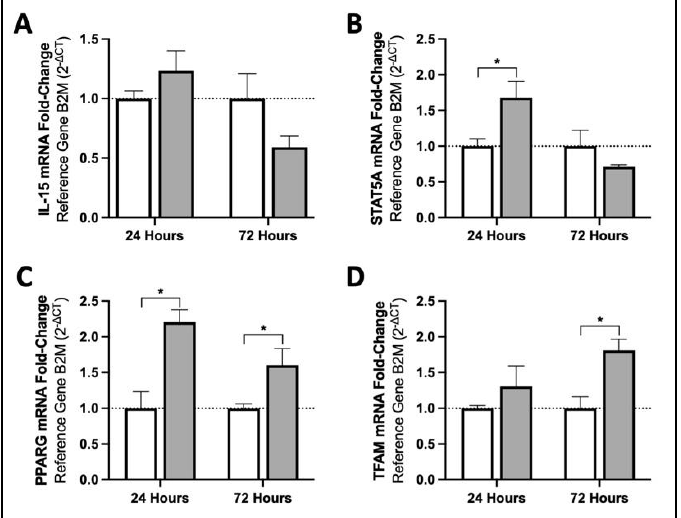
Figure 1. MIS elevates mRNA abundance for mitochondrial biogenesis activators in human fibroblasts via downstream targets of IL-15. ( A ) IL15 mRNA content remains unchanged by MIS supplementation. ( B ) Early elevations in STAT5A and ( C ) PPARG mRNA content are associated with ( D ) later elevations in TFAM mRNA content. White bars indicate CON treatment, grey bars indicate MIS treatment. n = 3 independent donor biopsies per group. Data are mean ± SEM. * indicates p < 0.05 via unpaired t -test.